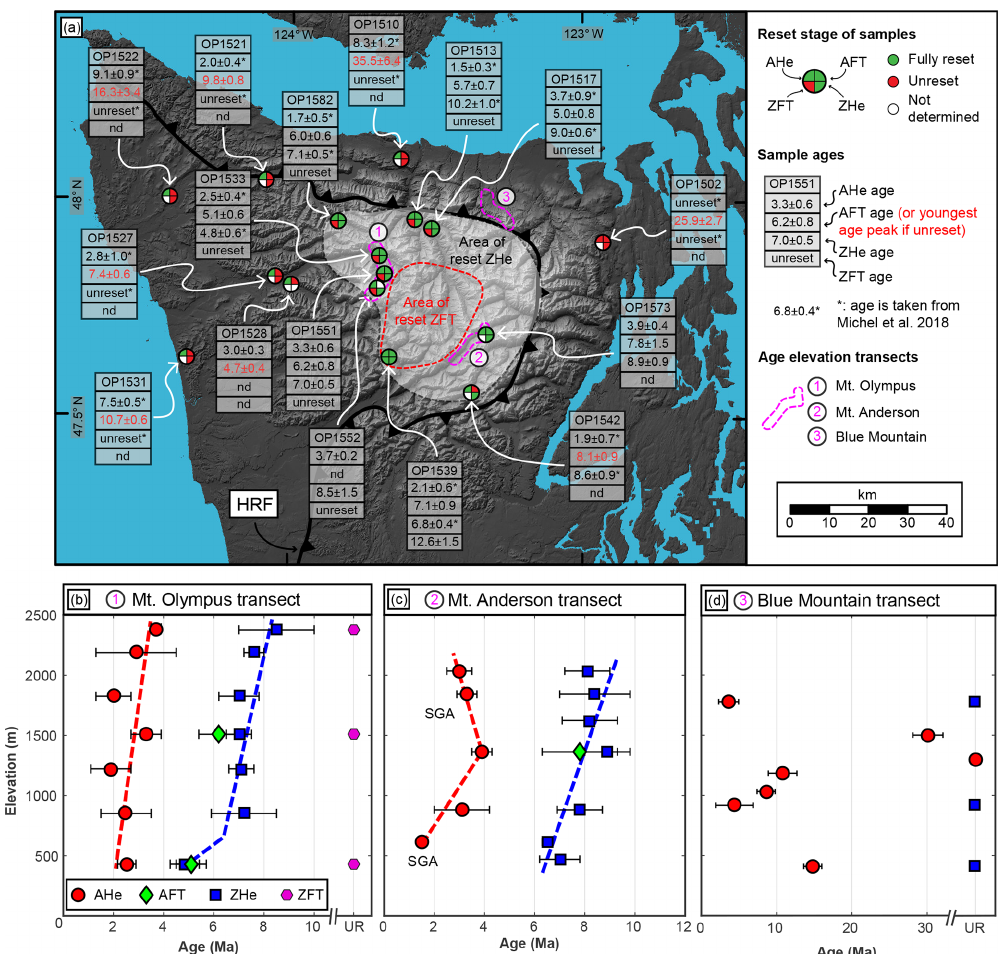
Figure 4. (a) Map of samples for which three to four different thermochronometer systems are available. The pie charts show the reset stage of a particular thermochronometer system for the sample. If AFT ages are unreset, the peak age of the youngest age population is given as the sample age (see Table 3 for older populations). Ages denoted with an asterisk are taken from Michel et al. (2018). The Hurricane Ridge Fault (HRF) separates the rocks of the accretionary wedge from the surrounding Coast Range Terrane in the hanging wall. The locations of the three different elevation transects (Mt. Olympus, Mt. Anderson, and Blue Mountain) are indicated on the map and the resulting age–elevation plots are shown in (b) to (d) . In (b) and (c) the dashed colored lines correspond to possible exhumation rates interpreted from the respective thermochronometer. All uncertainties are 1 standard deviation, SGA: single-grain